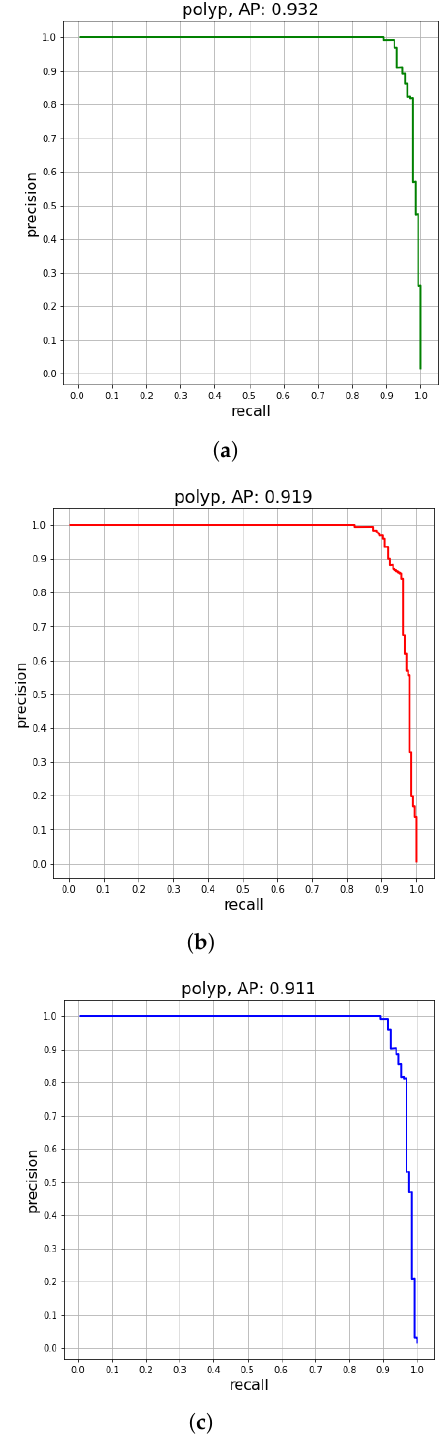
Figure 10. Precision vs. recall for ( a ) WCE test set, ( b ) CVC-ClinicDB test set, and ( c ) ETIS-Larib test set using the Hyb-SSDNet